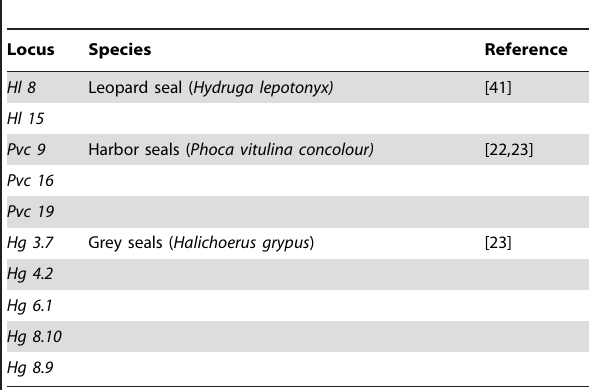
Table 1. Microsatellite loci listed by species in which the locus was initially